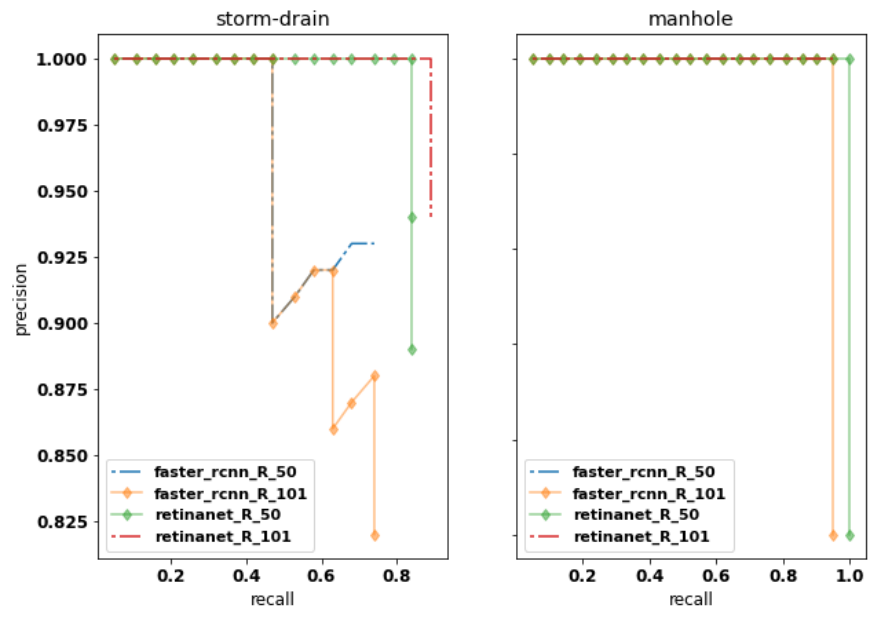
Figure 5. Precision–recall curves for all methods (R_50 and R_101 means ResNet-50 and ResNet-101, respectively) to the division 76-12-12. on IoU threshold at 0.5 (AP50).